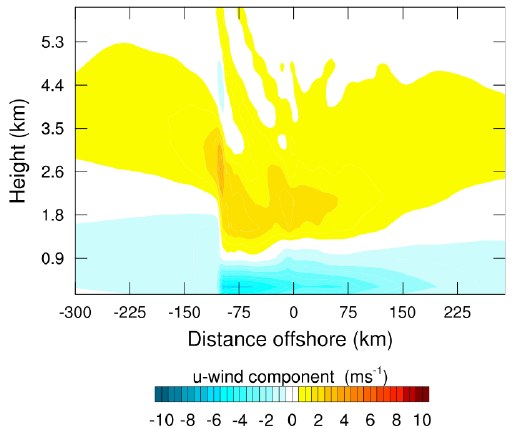
Fig. 15. Cross-section of a mature corkscrew sea breeze at 19:00UTC developing in 2ms − 1 along shore gradient flow for the single coast case. The PBL used was the YSU scheme and the SST was 287K. The u-wind component is positive in the offshore direc- tion.